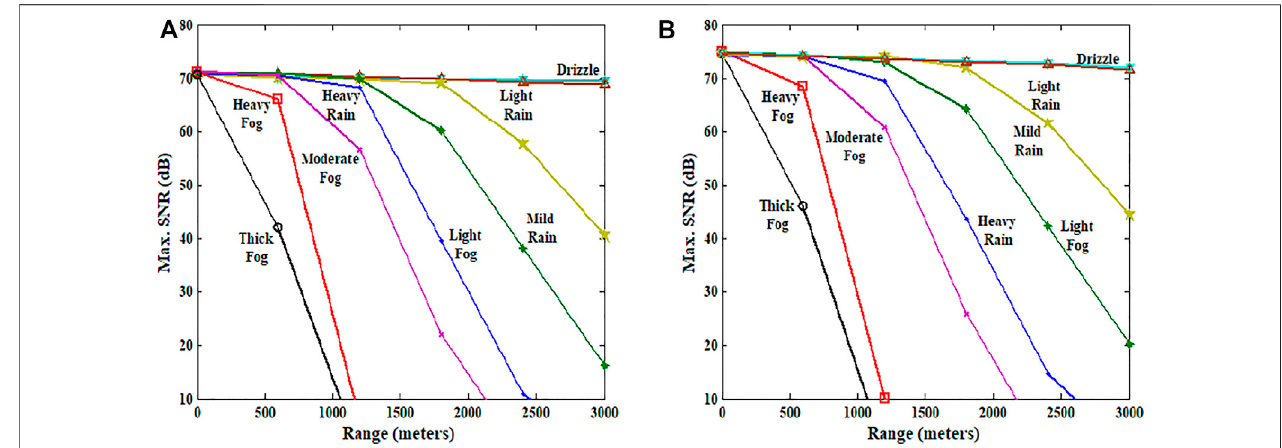
FIGURE 6 | SNR (dB) vs range at different attenuation levels (atmospheric conditions) at (A) 10 µsec and at (B) 30 µsec.